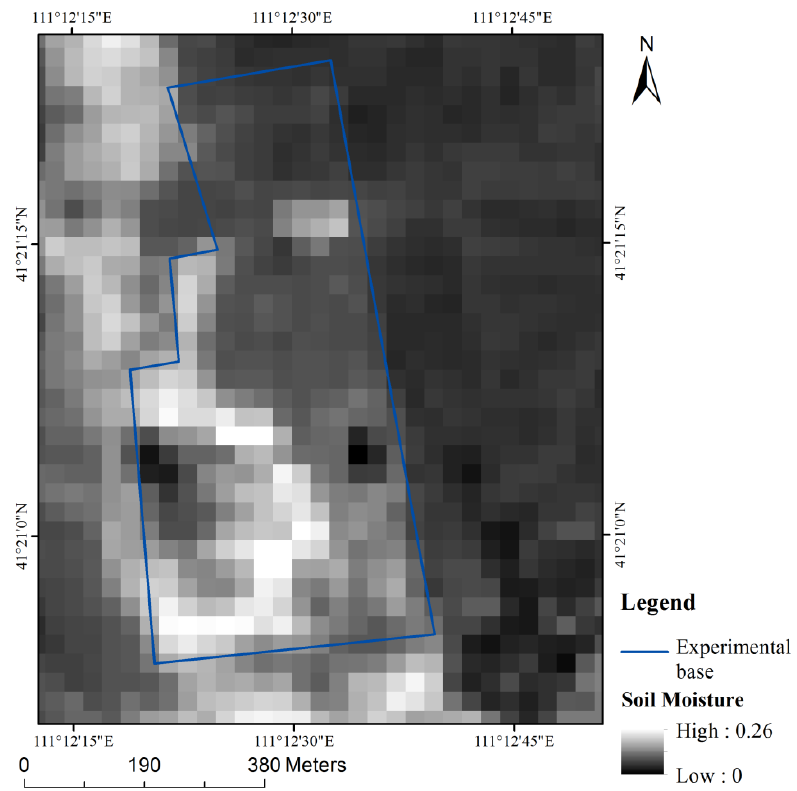
Figure 9. Spatial distribution of soil moisture in the study area obtained by Landsat 8. Table 4. Ground validation of remote sensing soil moisture by point